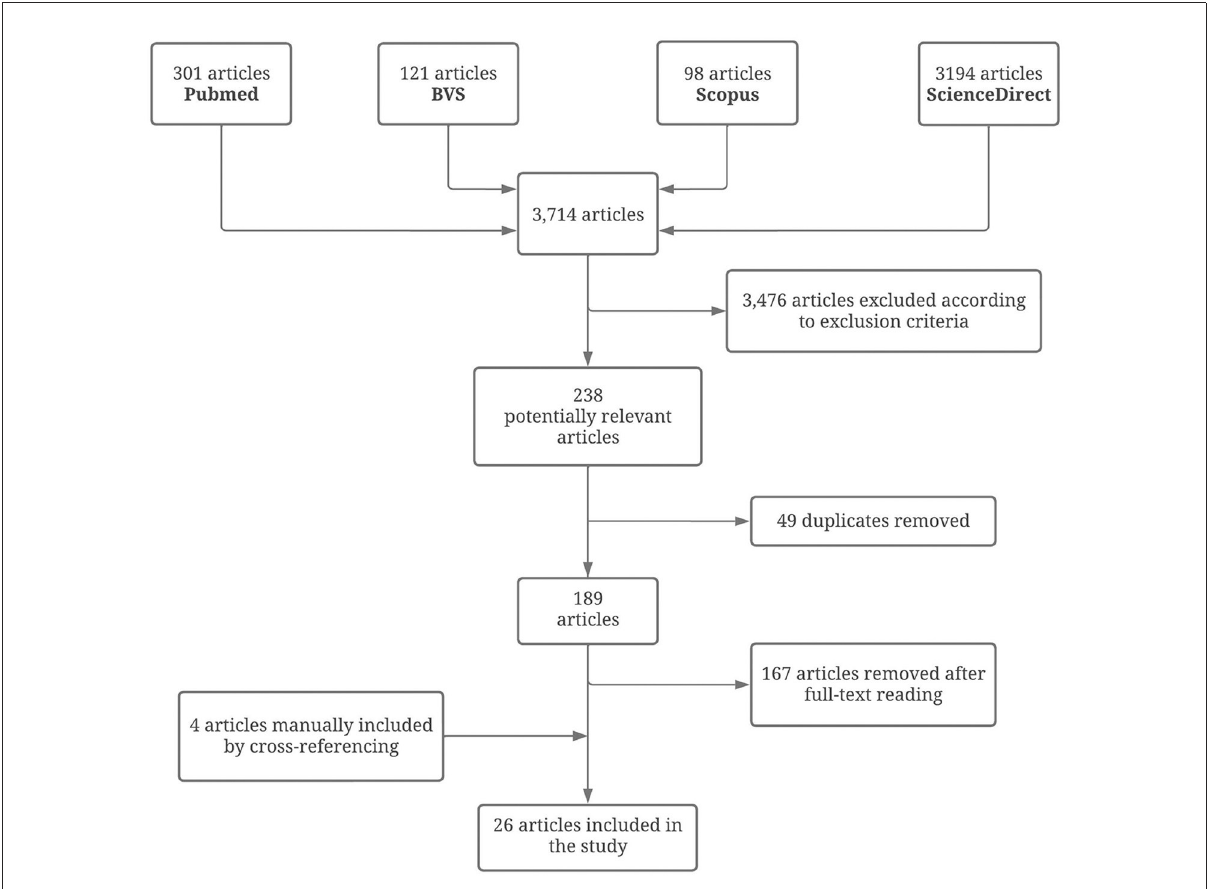
FIGURE1 PRISMA flow diagram resuming the literature review